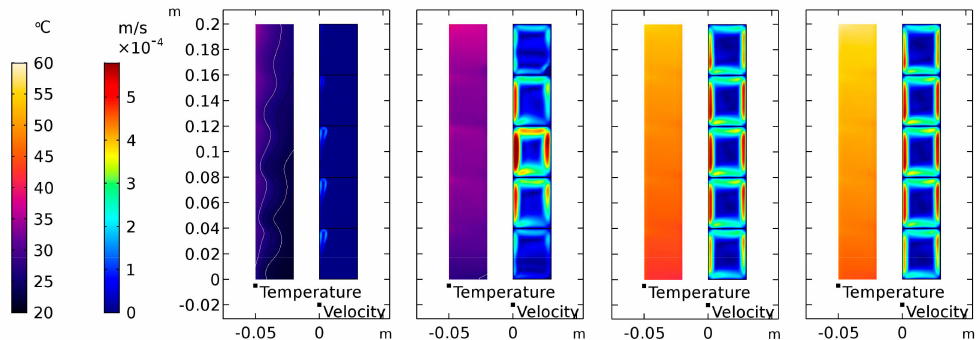
Figure 13. Results of the step 3 simulation for the segmented block (5 segments of 3 × 4 cm 2 ) with di ff erent PCM melting temperatures after 4, 8, 12 and 16 h (from left to right); black line in temperature contour plot is the 25 ◦ C isotherm; white lines are the 23 ◦ C respectively 27 ◦ C isotherms. PCMs